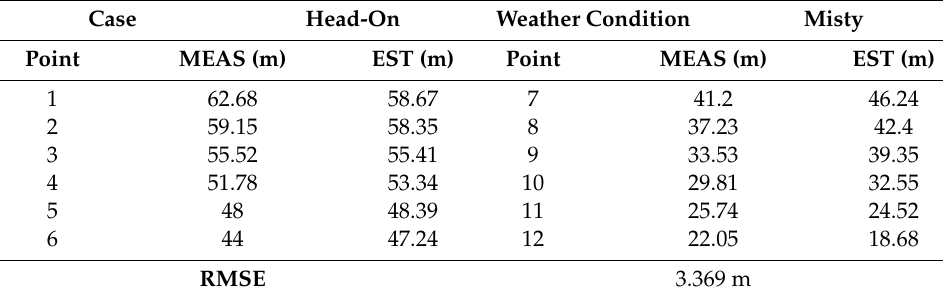
Figure 22. Result of model evaluation in Experiment 1. Table 6. Experiment 1 (estimation vs. GPS measurement).